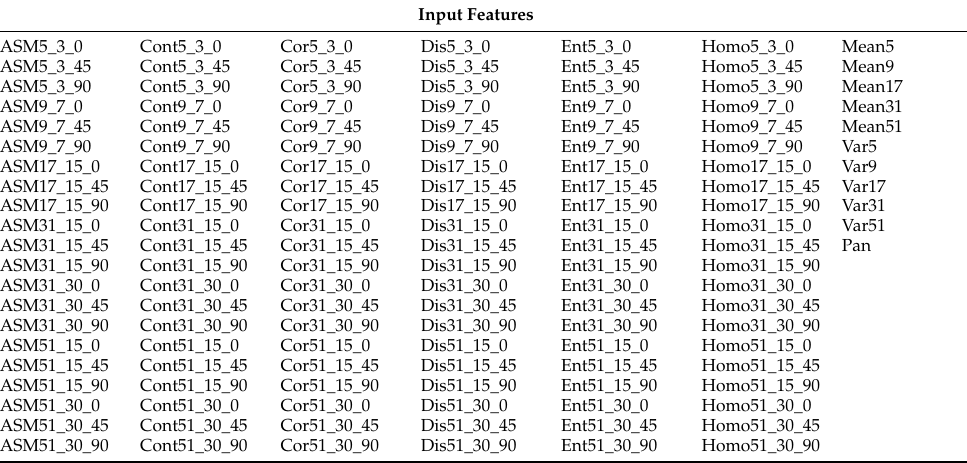
Table A7. All the textural features, as well as the panchromatic band, were coded based on the proposed protocol used in the classification (137 features).